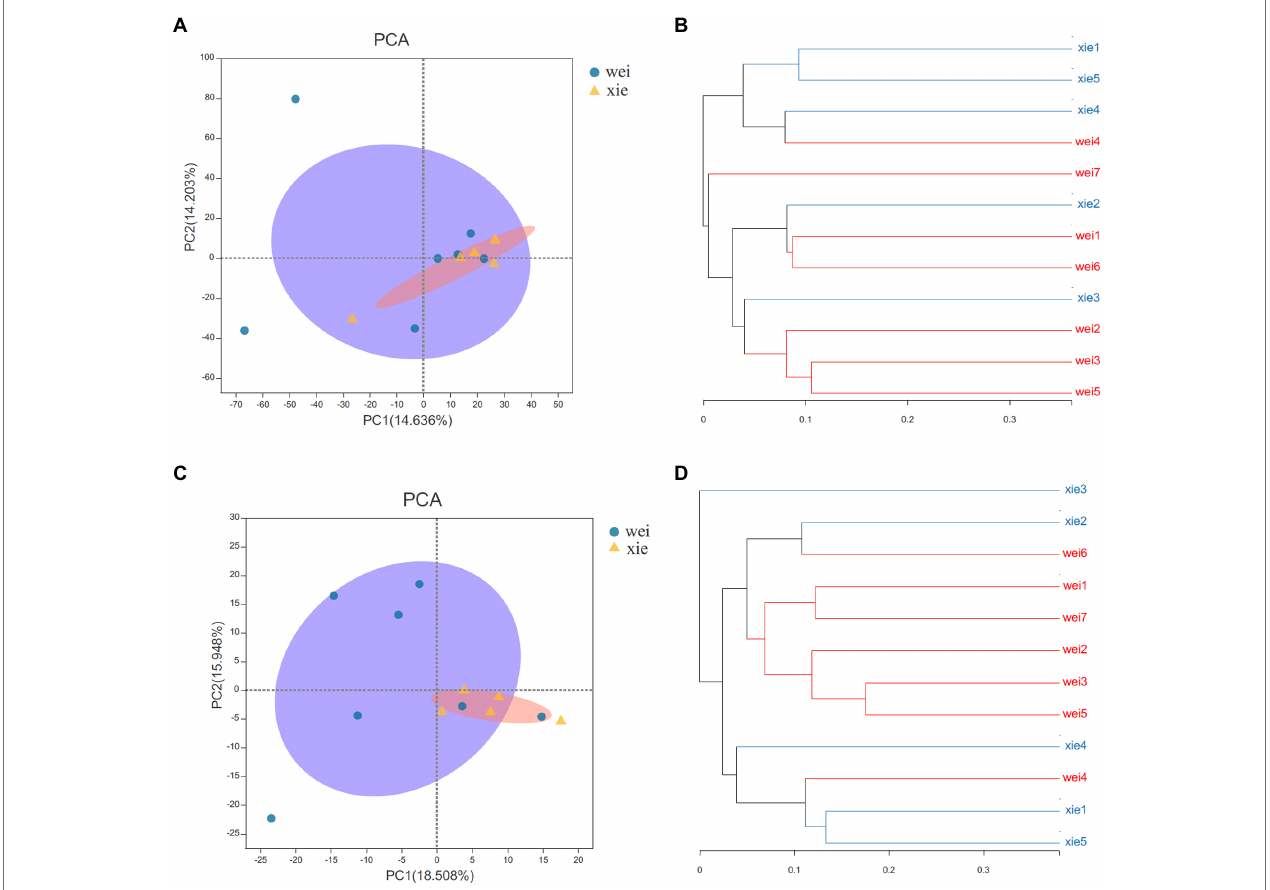
FIGURE 3 | Principal component analysis (PCA) plots and UPGMA tree based on the weighted UniFrac distance metric of microbial and actinobacterial communities from the Xieyang and Weizhou Islands using 16S rRNA gene amplicon data. (A) PCA plots of the entire bacterial community profiles. The microbial communities from Xieyang Island formed a closer group than those from Weizhou Island ( t -test, p < 0.05; two-sample Wilcoxon test, p < 0.01). (B) The UPGMA tree of the whole bacterial communities. No significant differences were indicated between the Weizhou and Xieyang Islands (Anosim, R = 0.105, p > 0.05). (C) PCA plots of actinobacterial community profiles. The actinobacterial community from Xieyang Island formed a closer group than those from Weizhou Island ( t test, p < 0.05; two-sample Wilcoxon test, p < 0.01). (D) The UPGMA tree of the actinobacterial community. No significant differences are shown in the actinobacterial community between the Weizhou and Xieyang Islands (Anosim, R = 0.279, p > 0.05) were shown. All the data were normalized before being subjected to statistical